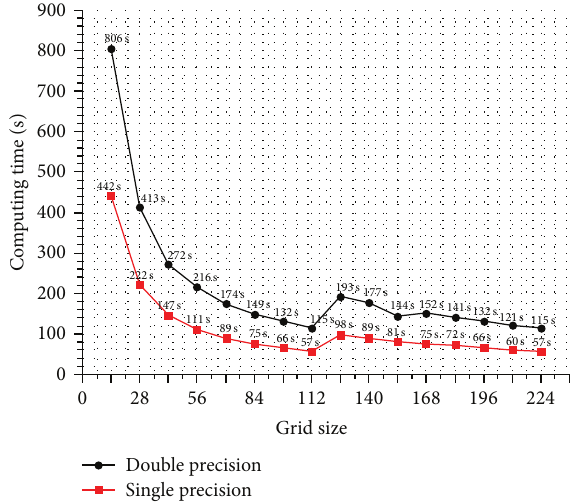
Figure 10: Speed-up of the behavior by increasing the quantity of blocks in double and single precision for a constant block size of 32 threads, with the respective quantity of required memory.